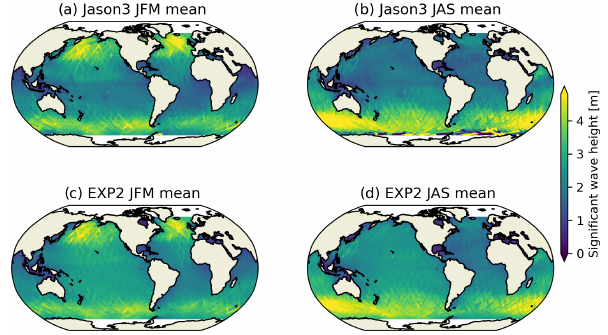
Figure 12. Length scale of summer (JAS and JFM for the North- ern Hemisphere and Southern Hemisphere, respectively) surface mixed-layer instability ( L sml ) of Argo observations (a) . The dif- ferences in L sml between EXP1 and Argo and between EXP2 and EXP1 and the zonal mean L sml are shown in (b) , (c) and (d) , respec- tively. The mean error in L sml decreases from − 0 . 96km in EXP1 to 0.05km in